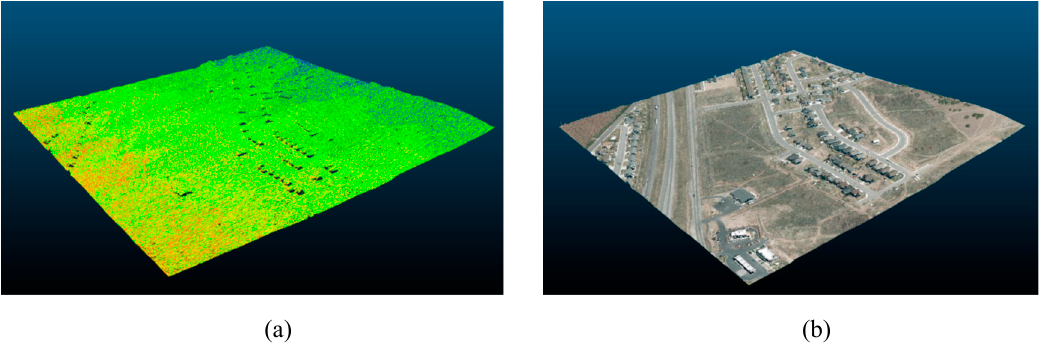
Figure 1. Experimental area. ( a ) LiDAR data for the year 2008; ( b ) LiDAR data for the year 2013.